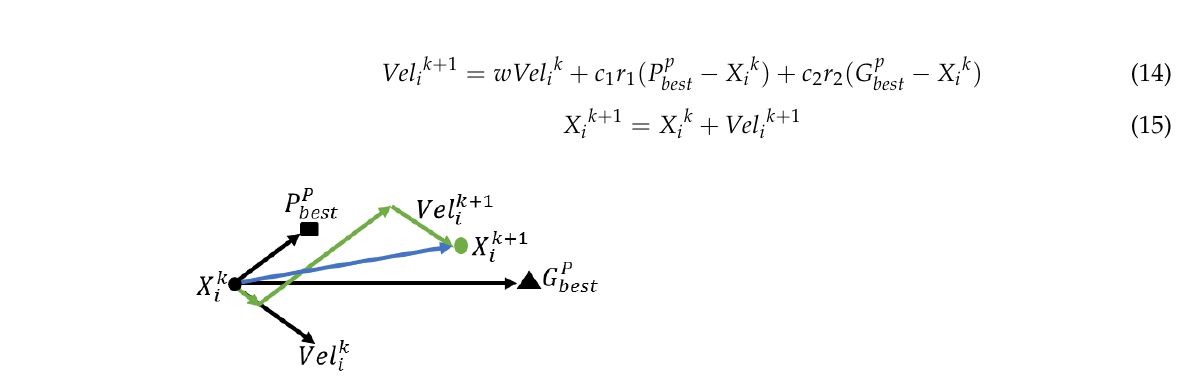
Figure 2. Movement of a single particle in